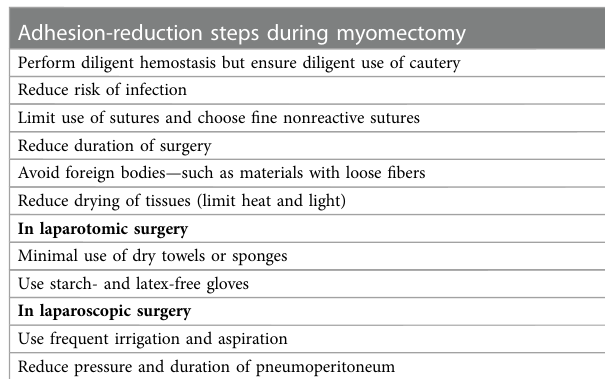
TABLE 1 Strategy for adhesion reduction during